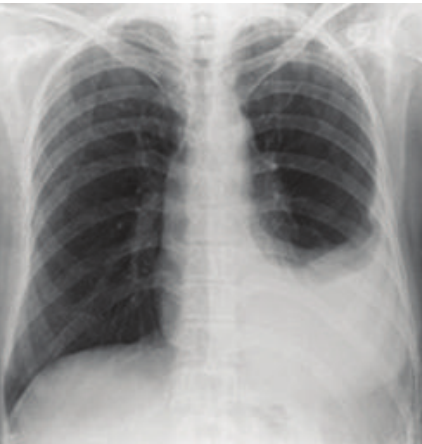
Figure 1: A free-flowing pleural effusion through left middle zone in chest X ray.